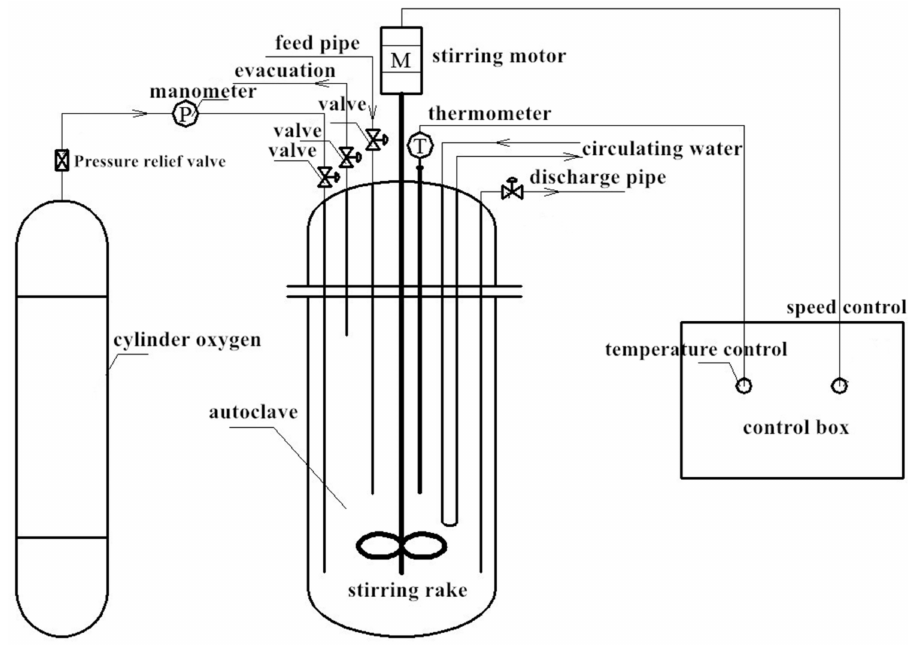
Figure 1. Structure schematic diagram of the reactor and reaction process for the preparation of